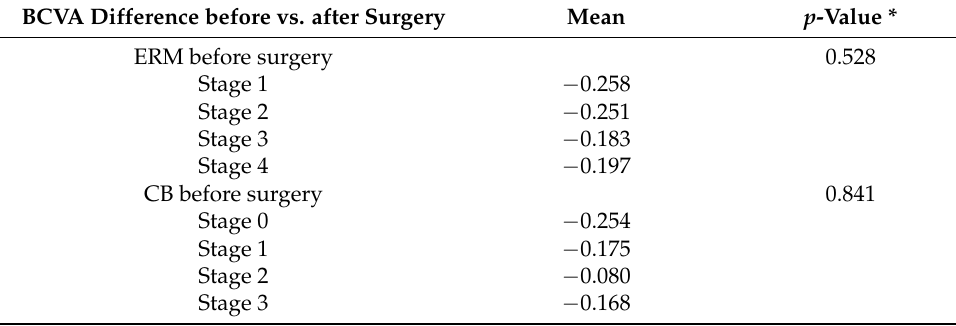
Table 3. Influence of surgery on best corrected visual acuity (BCVA) difference stratified by base- line parameters. BCVA Difference before vs. after